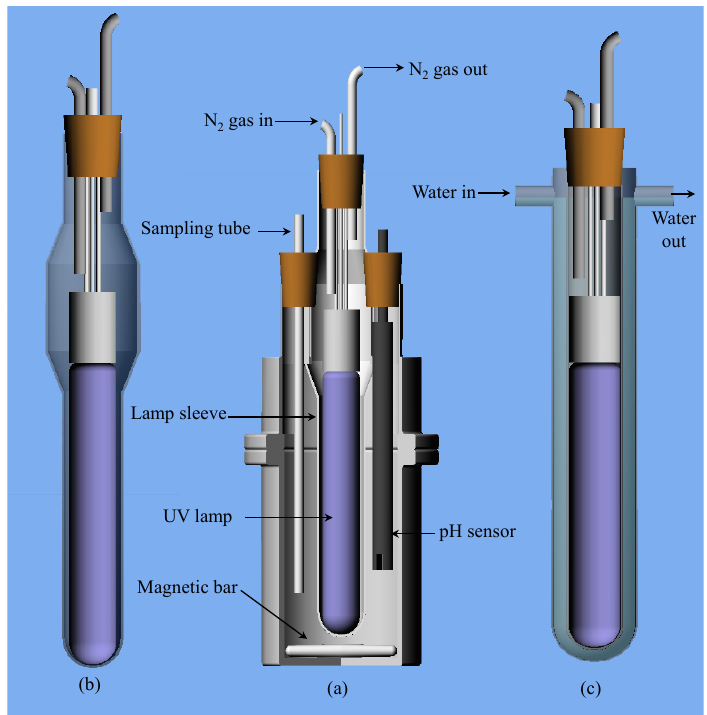
Figure 1. Schematic diagrams of (a) reactor setup, (b) single-layered synthetic fused silica glass lamp sleeve and (c) double-layered fused silica glass lamp sleeve with water circulation between the